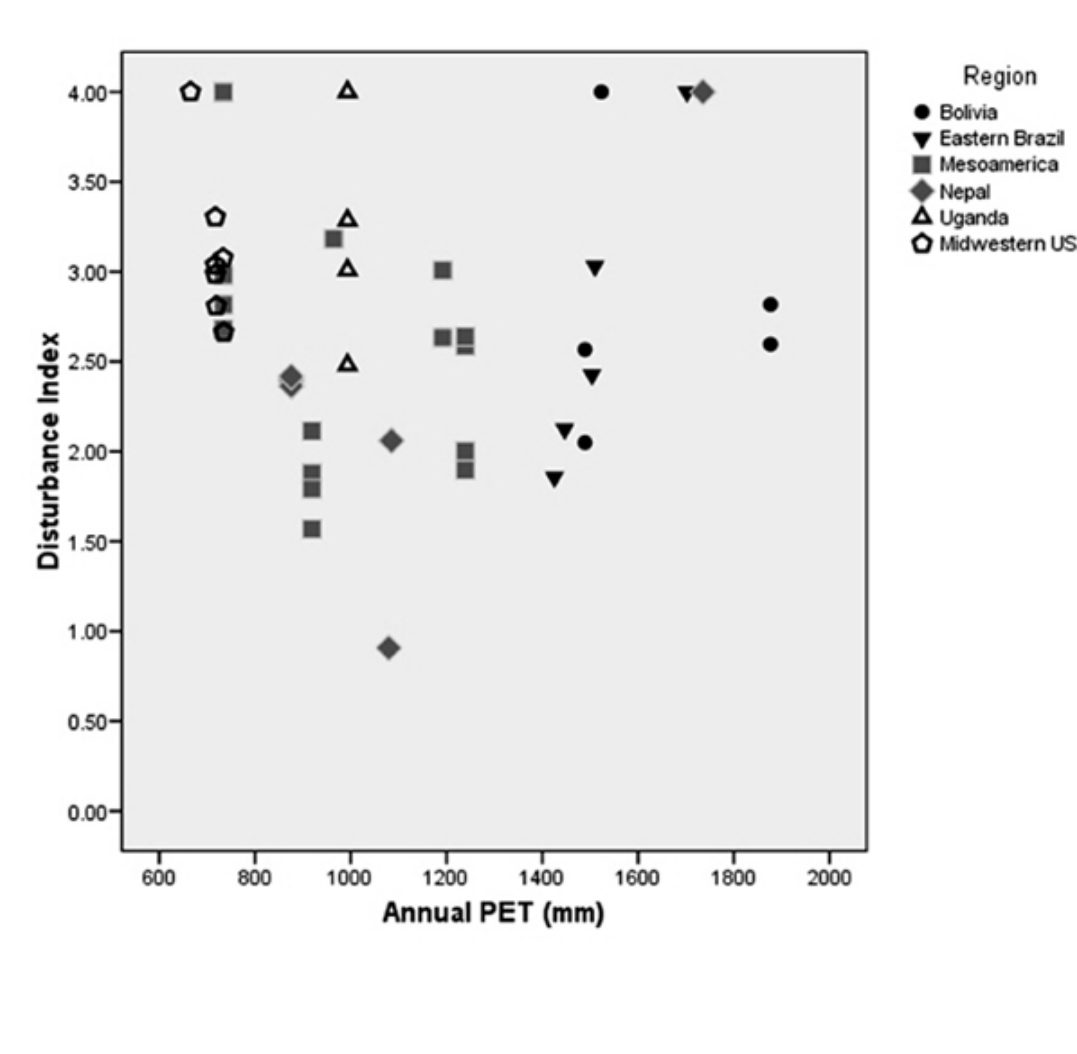
Fig. 2. Estimate of relative human disturbance. The disturbance index values of the study forests relative to their corresponding reference forest plotted as a function of the PET for each site. Values for the six reference forests are equal to 4.0 and appear at the top of the